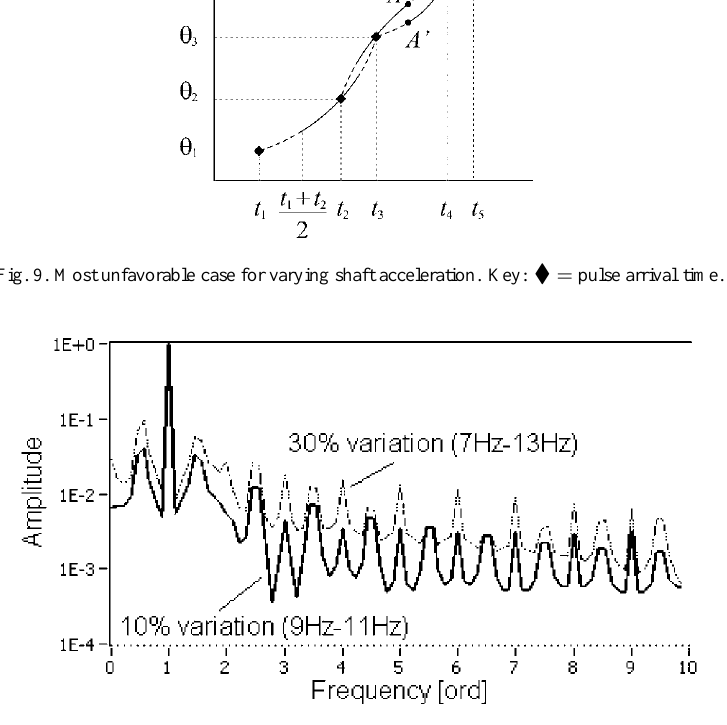
Fig. 10. Order spectrum with varying sinusoidal